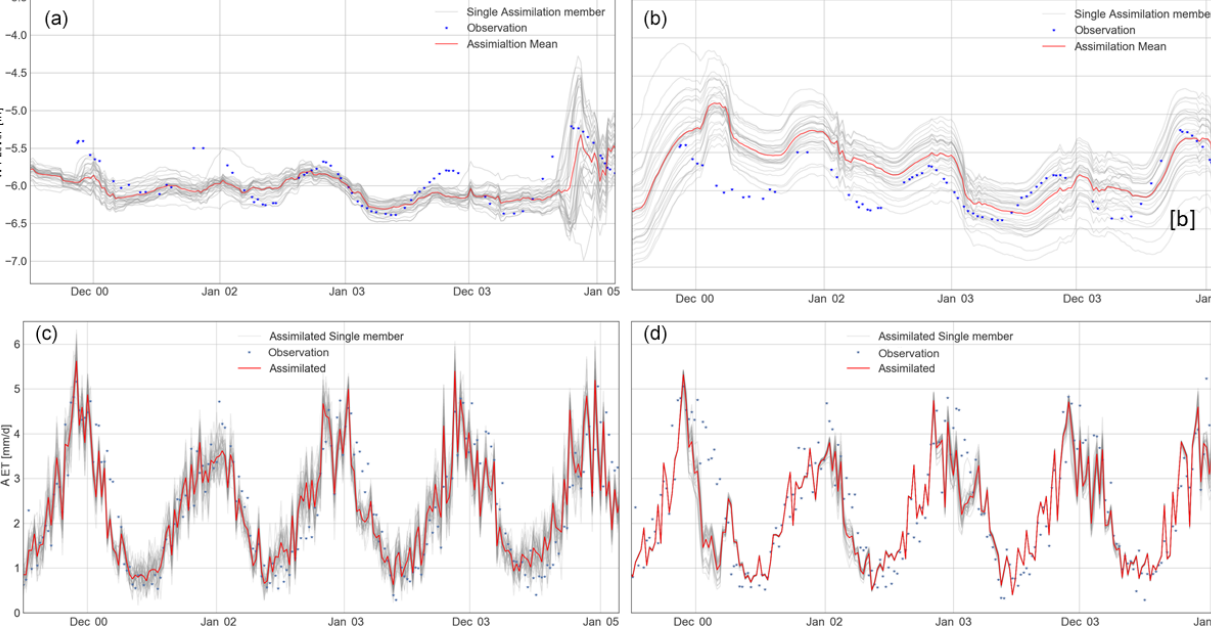
Figure 7. WT levels and AET and spread of the assimilation run for Configuration-1 (a, c) and Configuration-2 (b, d) . Table 3. RMSE, correlation and CRPS for three variables between the open loop and the assimilation.